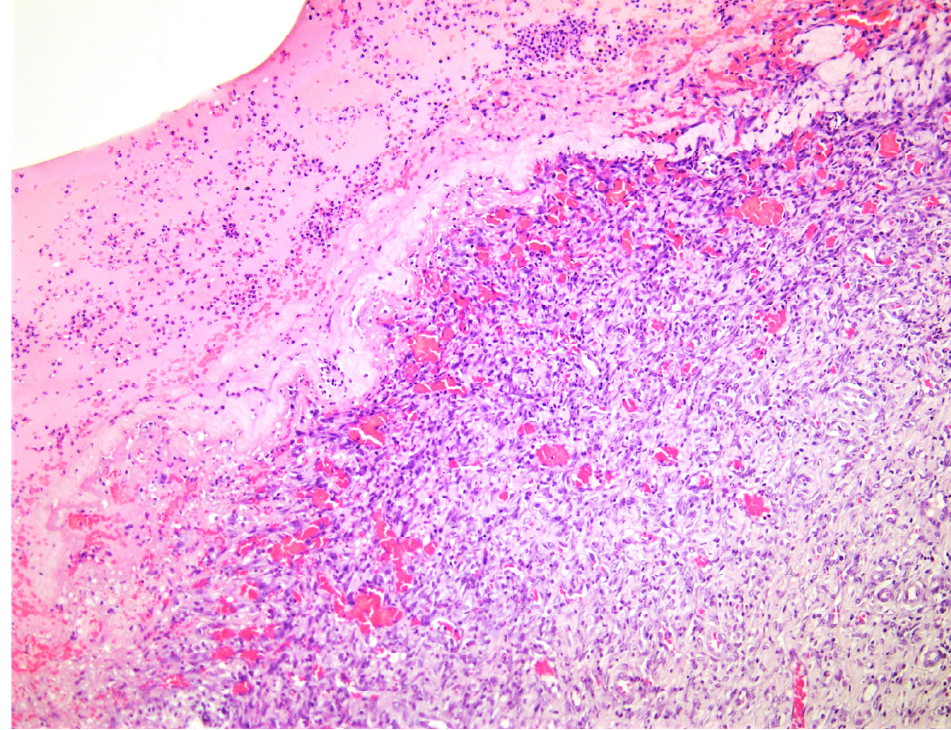
Figure A4. Histology of the wound treated with DNIC at post-operative day 7, hematoxylin and eosin staining, magnification—10×.